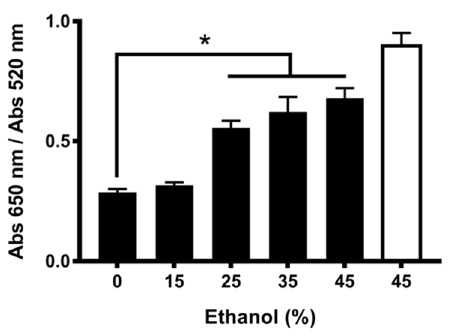
Figure 4. EtOH treatment recovers nfGNP aggregation in the presence of PsV. nfGNPs with increasing concentrations of ethanol were incubated with PsV (500 ng) in 70 mM NaCl. White bar, without PsV; black bars, with PsV. The plot represents the mean and standard deviation of three independent experiments. The asterisk indicates the statistical significance ( p = 0.0001).